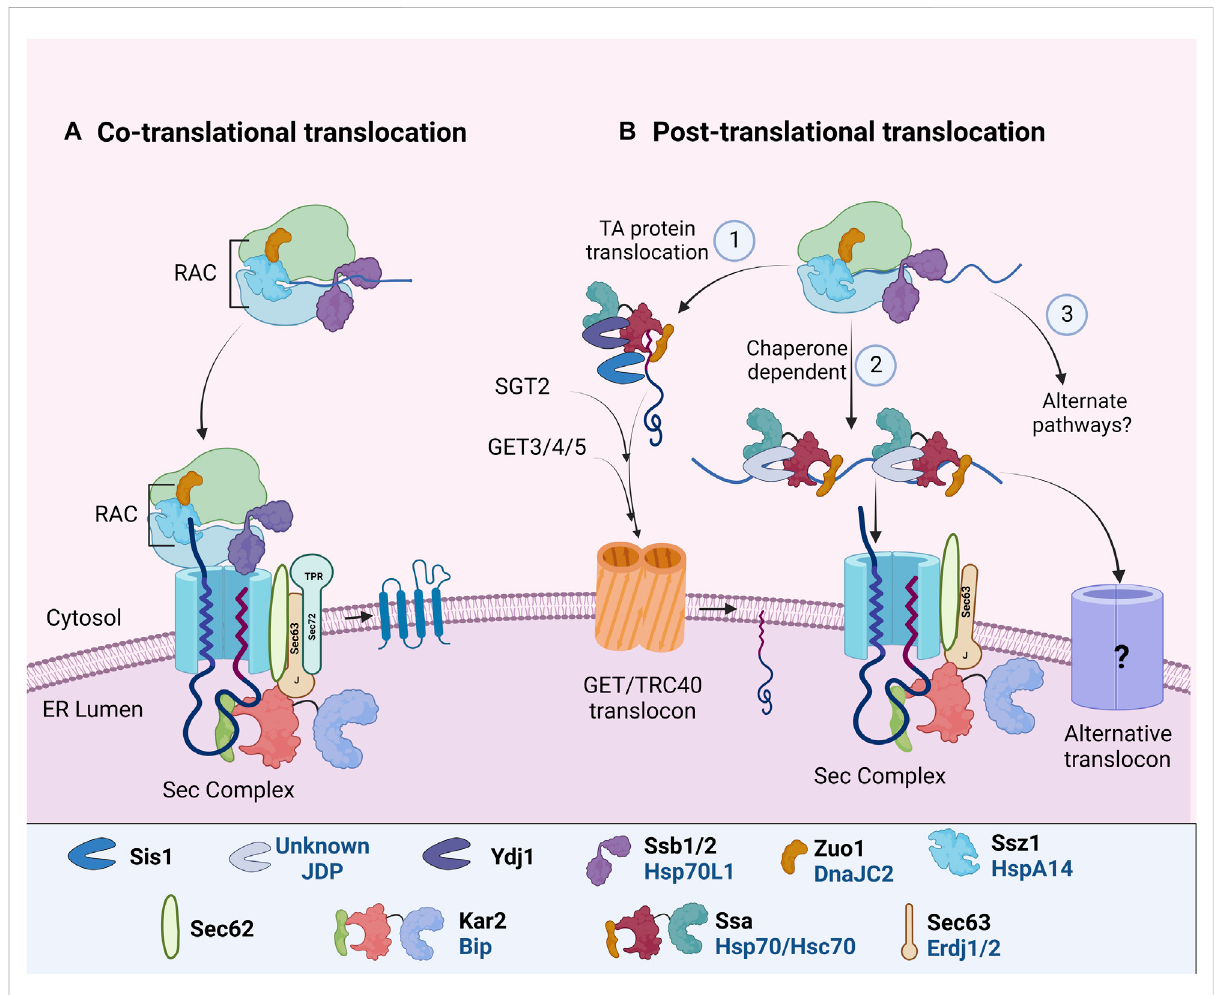
FIGURE 2 ER targeting and import of PM proteins. In different organisms, speci fi c Hsp70: JDPs mediate the ER targeting of PM proteins by (A) CTT or (B) PTT. During both CTT and PTT, ribosome-associated Hsp70:JDPs Y,H interact and protect the nascent polypeptides (Otto et al., 2005; Döring et al., 2017; Chen et al., 2022). PTT occurs through multiple pathways (1) GET/TRC40 mdiated Y, (2) Chaperone mediated H or (3) alternate pathways N (Rabu et al., 2009; Casson et al., 2017; Cho et al., 2021). Further, the ER-localized Hsp70:JDPs Y,H,A perform the protein import and lateral insertion of PM proteins (Ohta and Takaiwa, 2014; Pobre et al., 2019; Itskanov et al., 2021, p. 63). Y Literature available in Yeast; H Humans; A Arabidopsis. N No literature available. Names of Hsp70 and JDPs are denoted in different colors; Black for Yeast; Blue for